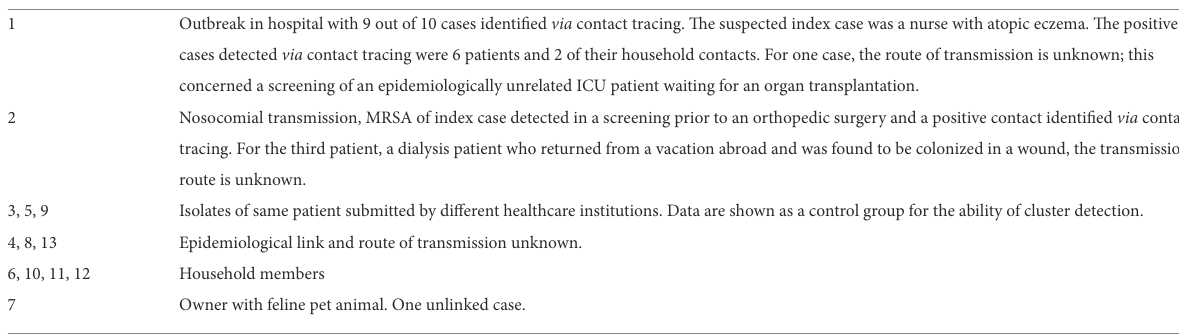
TABLE 2 Epidemiological background per